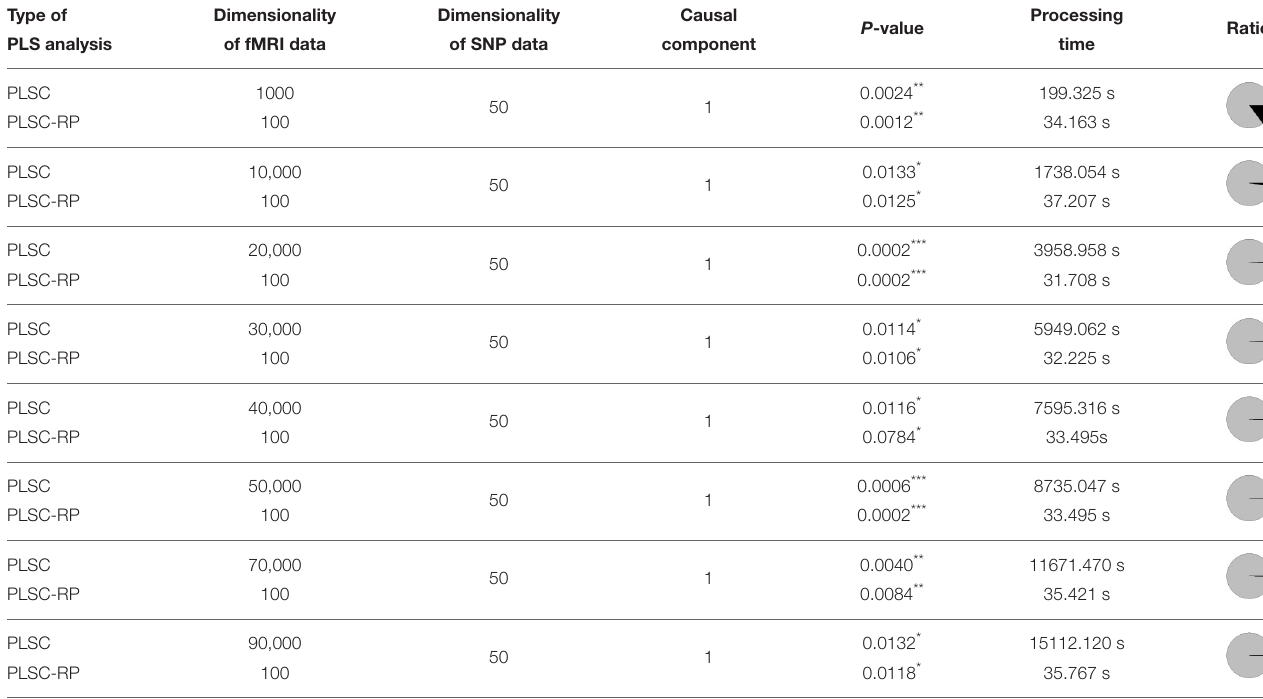
TABLE 1 | PLSC and PLSC-RP results for high-dimensional neuroimaging data. Type